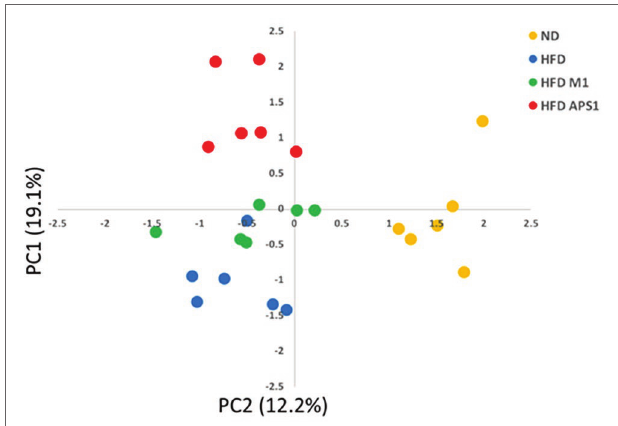
FIGURE 4 | PCA plot of metabolomics profile based on PC1 and PC2 from mean intensity values of total detected